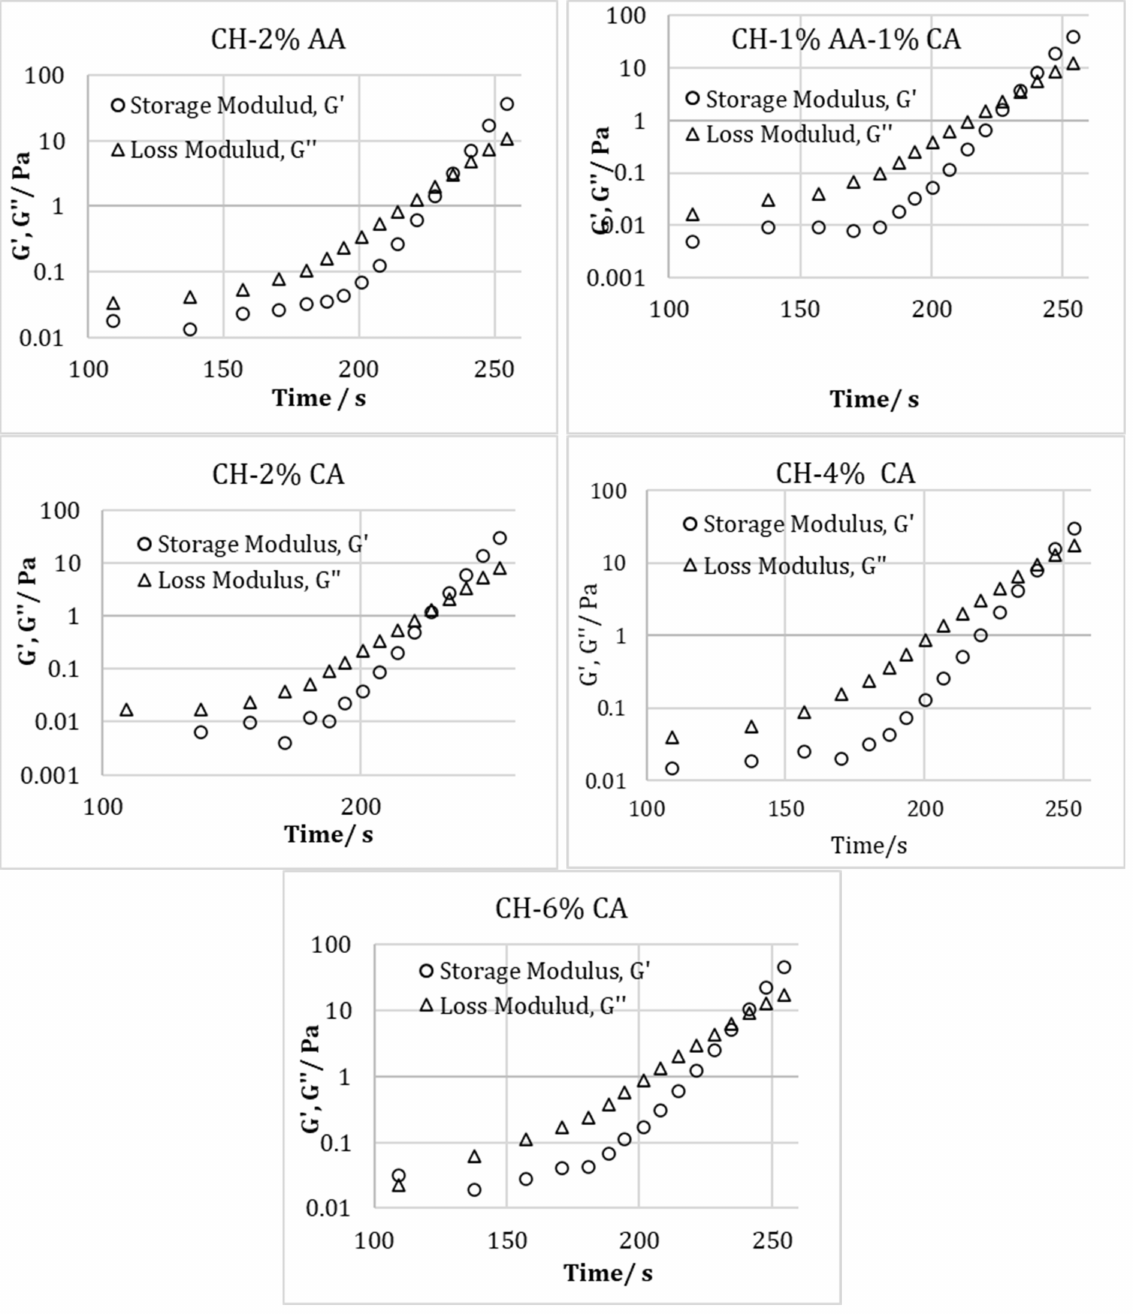
Figure 5. Relationship between Storage modulus (G (cid:48) ) and loss modulus (G (cid:48)(cid:48) ) vs time from oscil- latory frequency sweep of chitosan solution prepared using acetic acid (2% v / v ) and citric acid (2, 4, and 6% w / v